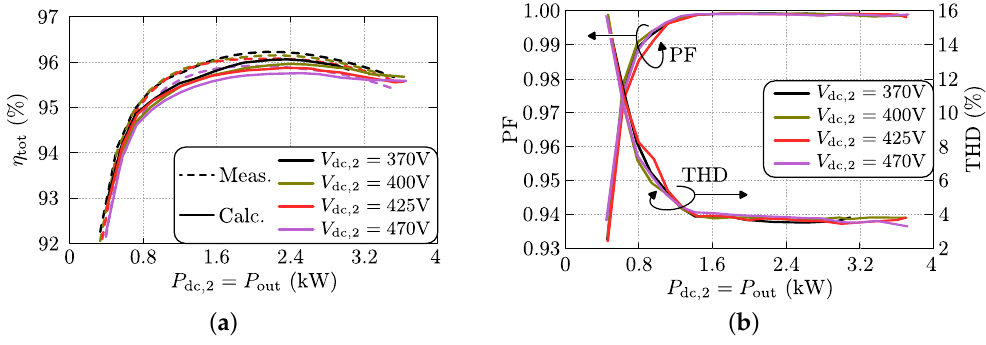
Figure 25. Measurement of ( a ) the efficiency and ( b ) the total harmonic distortion (THD) and (true) power factor (PF). The measurements are taken at the nominal ac input voltage of V ac = 230 V rms , in the complete power range (up to 3.7 kW output power), and at different dc output voltages.